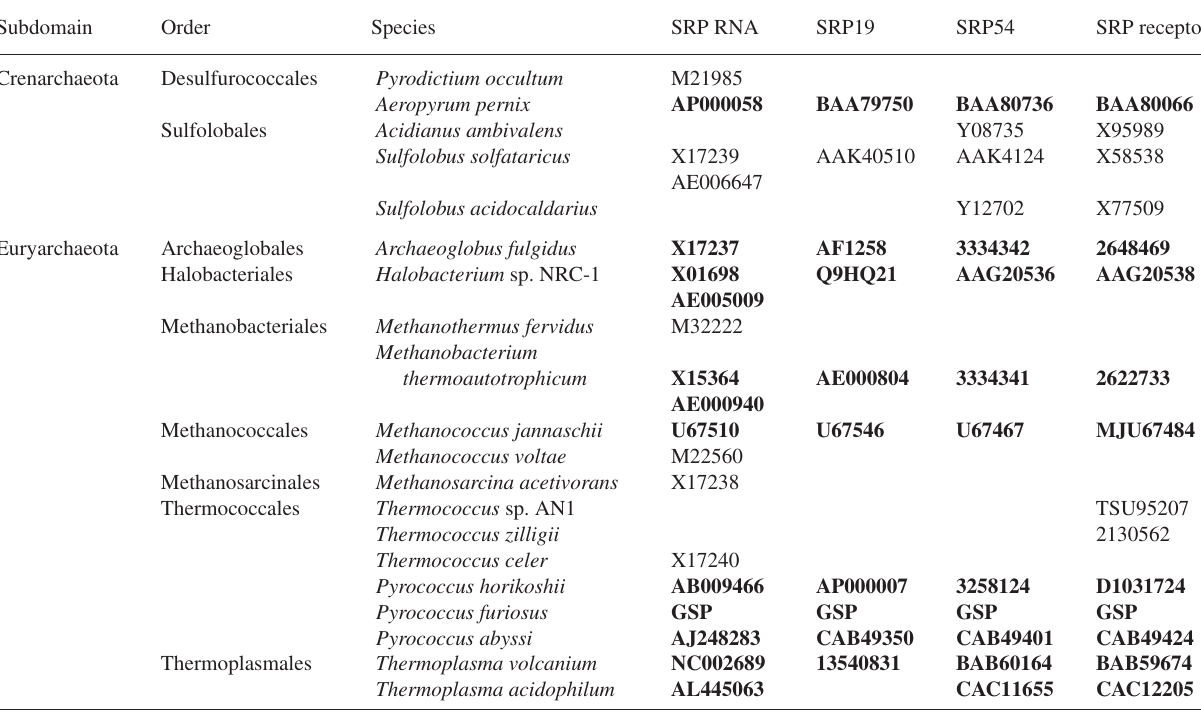
Table 2. Identified components of the signal recognition particle (SRP) pathway in Archaea, arranged according to NCBI taxonomy. Bolded ac- cession numbers represent sequences obtained from completed genomes, indicatingthat the failure to detect a given sequence in a particularstrain may be meaningful. GSP refers to a genome sequencing project with sequences that have not yet been submitted to GenBank. The Pyrococcus furiosus sequences were provided at http://www.genome.utah.edu/Pfu102000.gb. The listed sequences are accessible from the SRPDB at http://psyche.uthct.edu/dbs/SRPDB/SRPDB.html and its European mirror site at